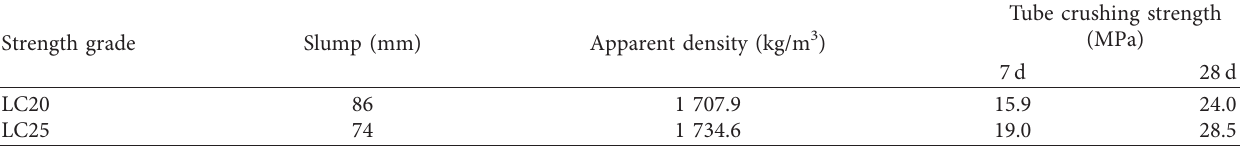
Table 13: Test results of benchmark mixture ratio.